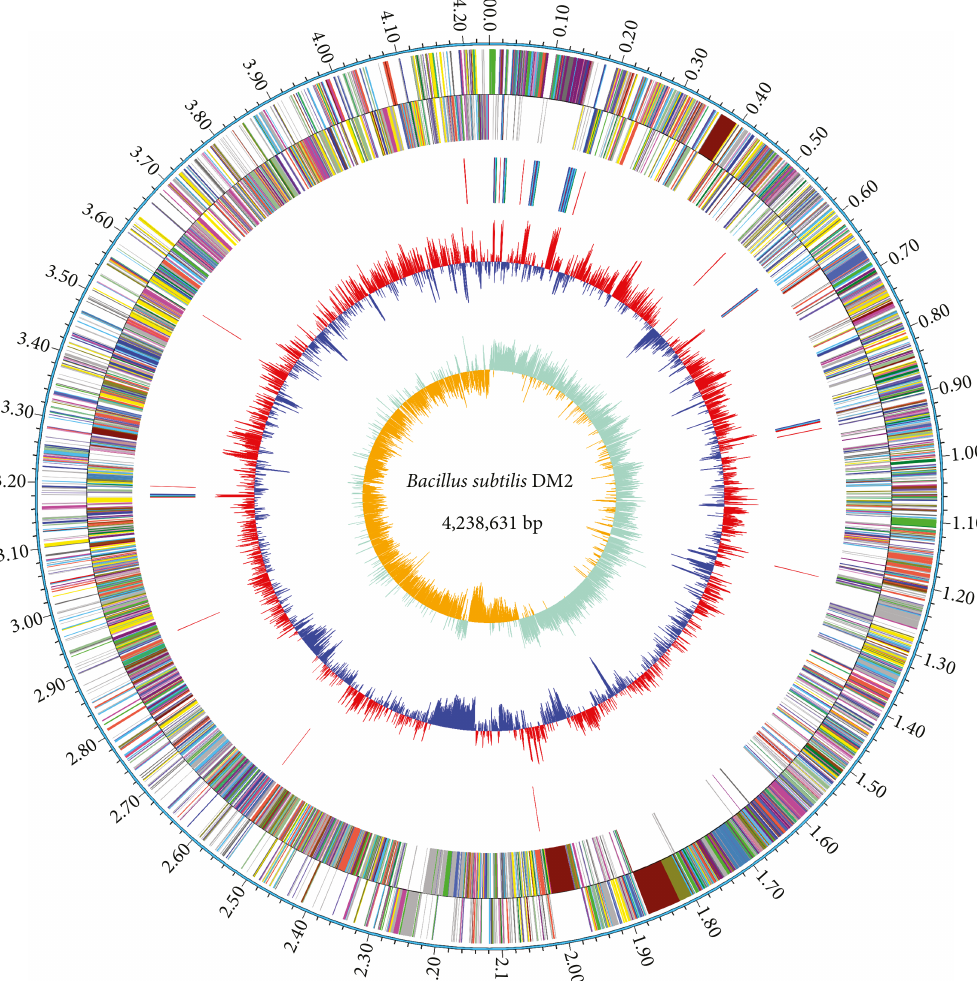
Figure 2: Circular chromosome genome of B. subtilis DM2. Circle 1 (from outside to inside) represents the genome size. Circle 2 represents the protein-coding genes in the positive strand of chromosome. Circle 3 represents the protein-coding genes in the negative strand of chromosome. Circle 4 represents rRNA and tRNA genes. Circle 5 represents G+C content, < average content (blue-colored), ≥ average content (red-colored). Circle 6 represents the GC skew (G-C)/(G+C).